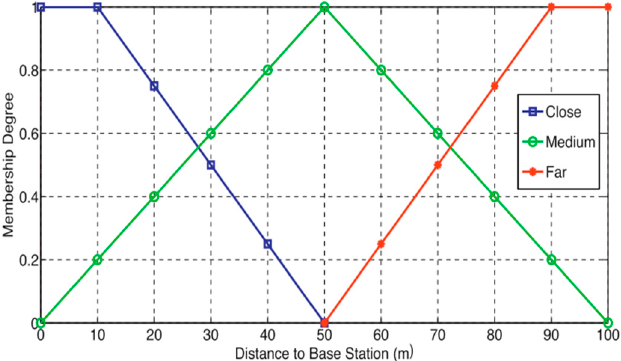
Figure 3. Fuzzy set for input variables of the distance between node and the BS (40).